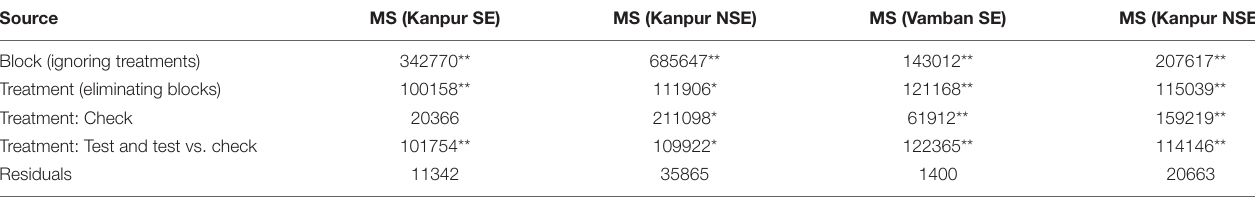
TABLE 2 | ANOVA of yield over stress and non-stress environments in IIPR, Kanpur and TNAU, Vamban. Source MS (Kanpur